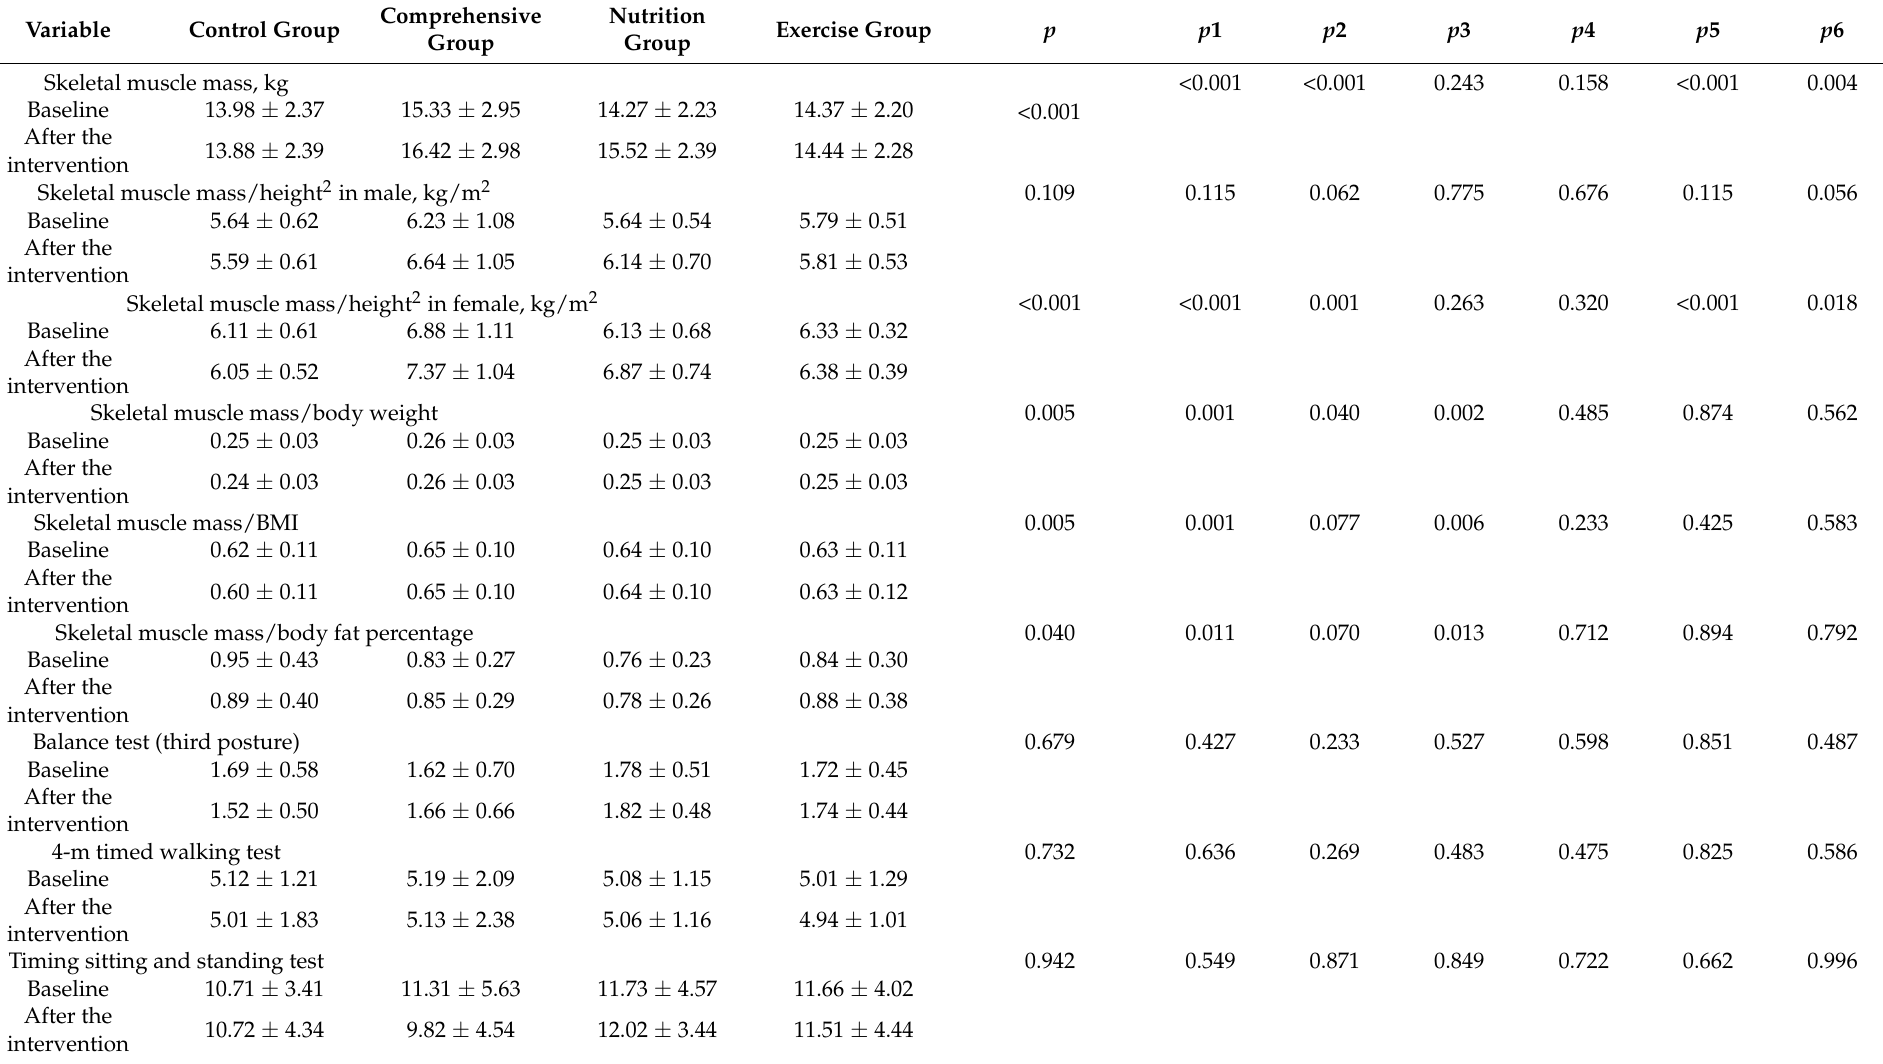
Table 4. Comparison of quantity and function of skeletal muscle before and after the